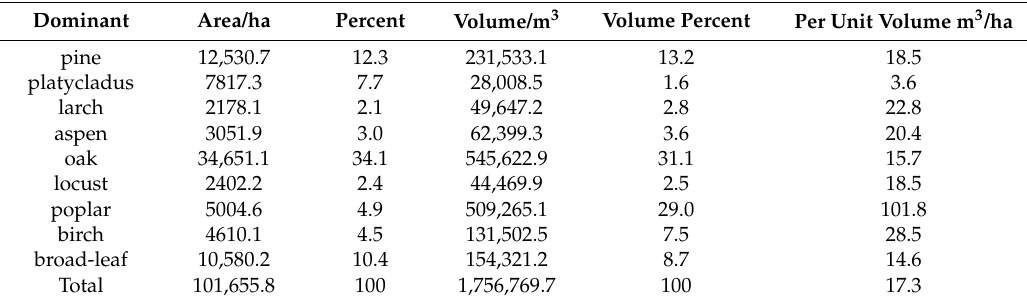
Figure 1. Digital elevation map of Yanqing. Table 1. Statistics of the areas and volume of dominant plant species in Yanqing.